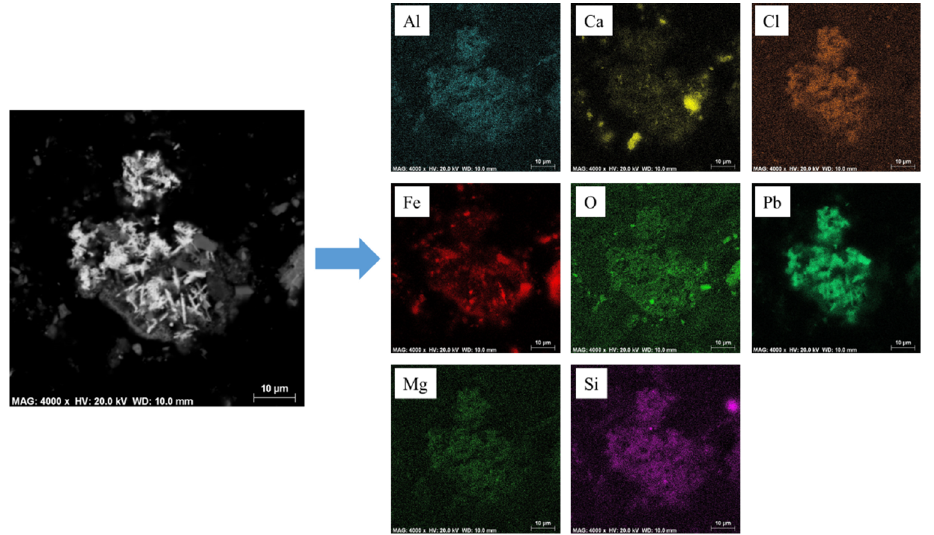
Figure 12. SEM-EDS examination on sintering dust leaching residue.